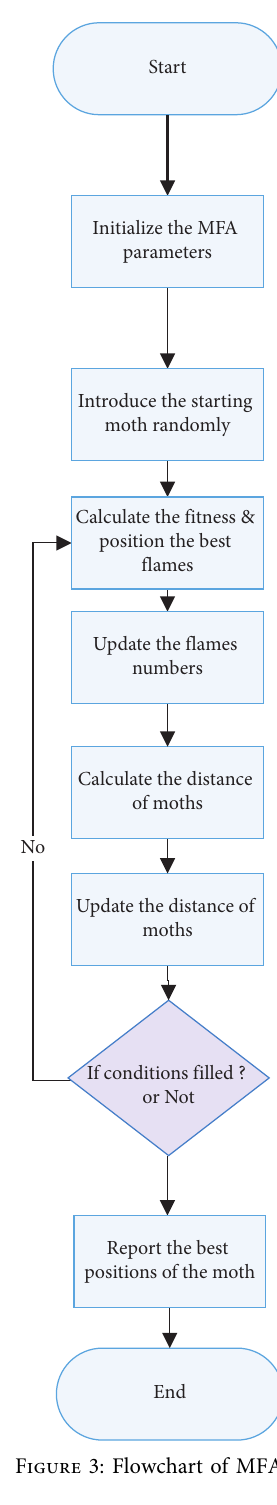
Figure 3: Flowchart of